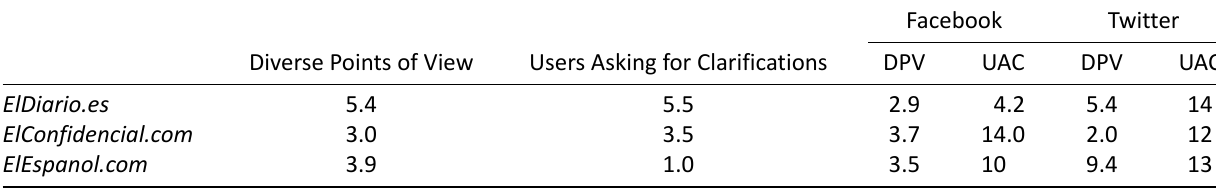
Table 8. Do participants provide different points of view and question each other and ask for clarifications on expressed views?